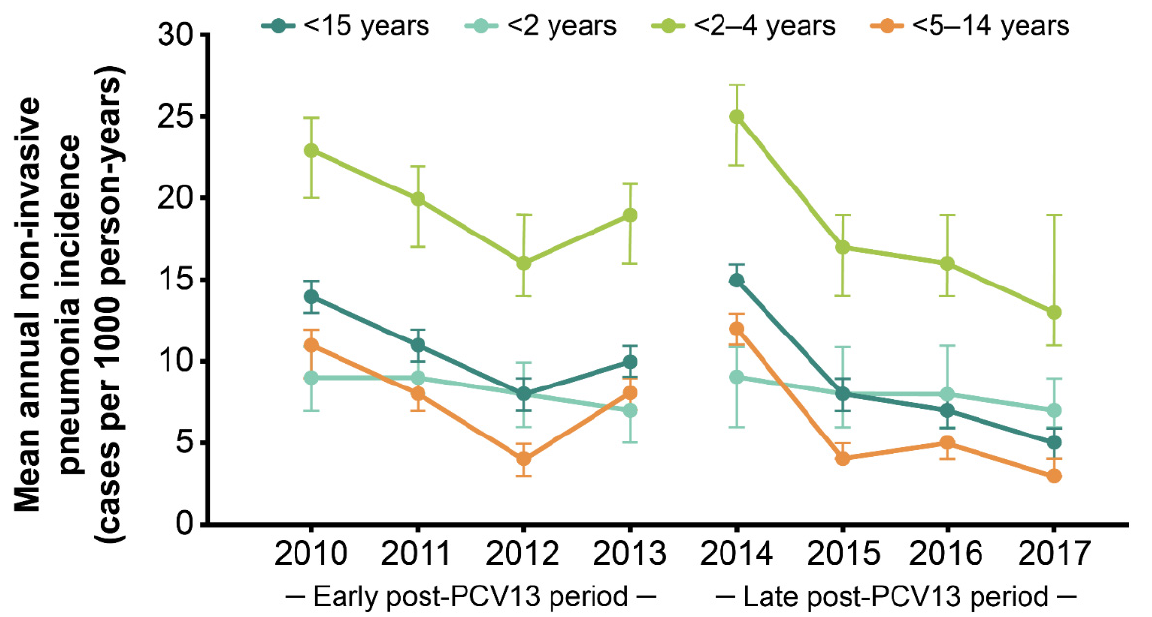
Figure 2. Changes in annual non-invasive pneumonia incidence following the introduction of PCV13. PCV13, 13-valent pneumococcal conjugate vaccine. Error bars indicate 95% confidence intervals. The results of the ITS analysis did not detect a significant change in the non-invasive pneumonia incidence in the early PCV13 period (Table 3). An immediate increase of 6.87% ( p = 0.091) was observed between the early and late PCV13 intervention periods (Table 3). In the late PCV13 period, the IRs gradually decreased by 2.8% ( p = 0.003) per year (Table 3 and Figure 2). The Mann–Kendall test showed a significant monotonic decreasing trend ( p = 0.026) over the study period. When stratified by age, similar significant trends in non-invasive pneumonia incidence were observed for children in the 2–4 years and 5–14 years age groups, with IRs decreasing by 3.5% ( p < 0.001) and 2.6% ( p = 0.027) per year in the late PCV13 period, respectively (Figure 2). In children <2 years of age, no significant trend was detected (Figure 2). In all 3 age groups, there was an unexpected rise in the IRs of non-invasive pneumonia in 2014, resulting in the immediate increase between the early and late PCV13 periods. Further analysis of the monthly IRs of non-invasive pneumonia revealed that there was a peak in pneumonia episodes in the spring and summer months of 2014 in the Veneto region, which was not evident in any of the preceding or subsequent years (Figure